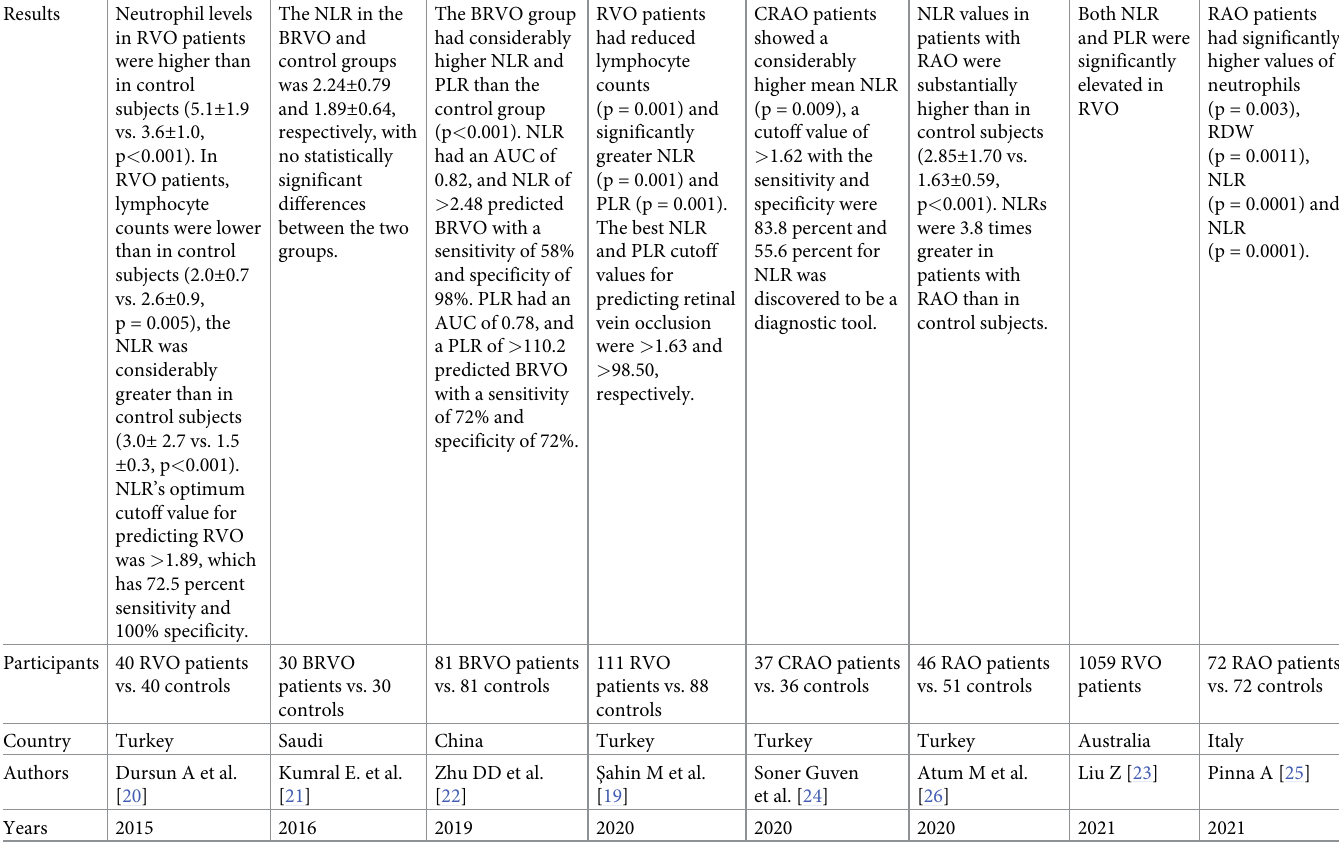
Table 1. Different potential biomarkers from routine blood analysis for predicting RAO or RVO reported in literature.